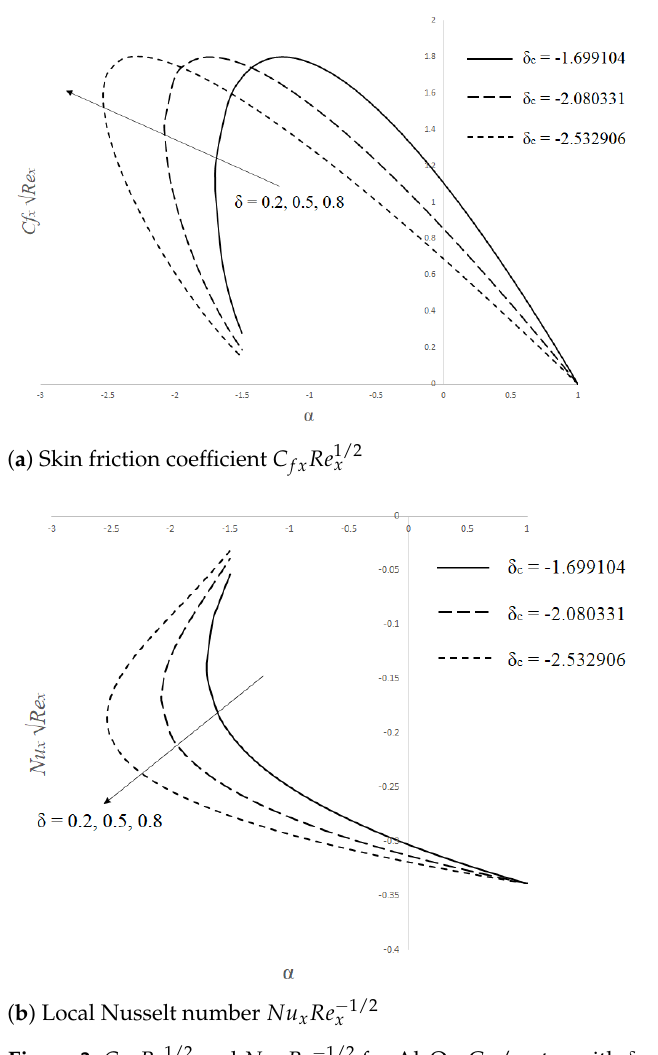
Figure 3. C fx Re 1/2 x and Nu x Re − 1/2 x for Al 2 O 3 –Cu/water with δ and α